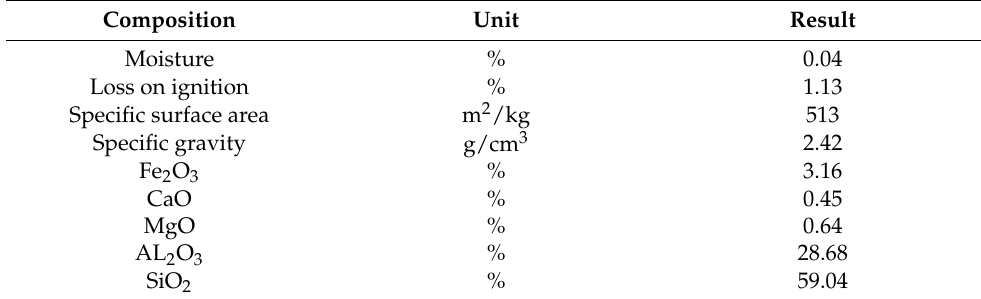
Table 1. Parameters of fly ash.